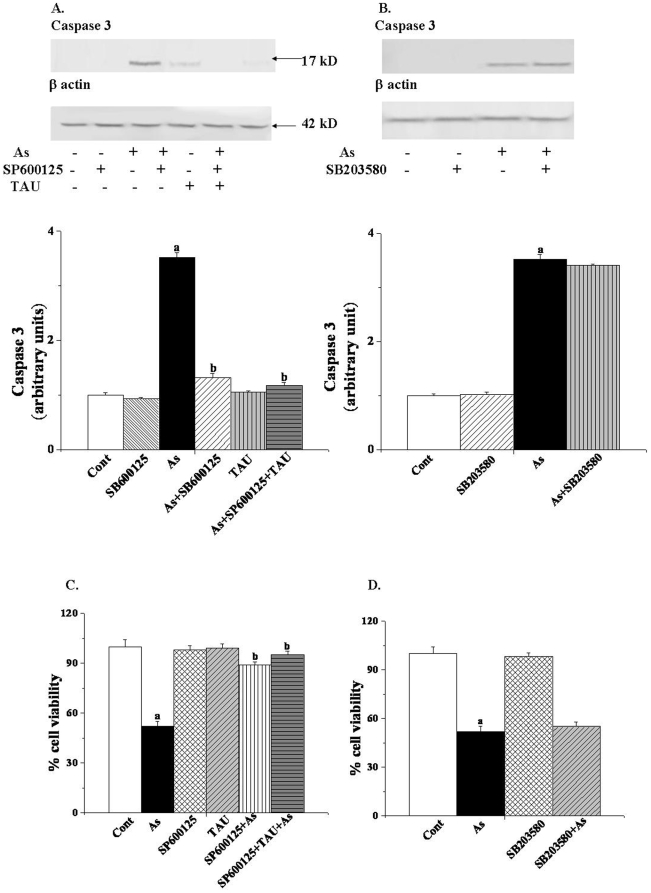
Immunoblot analysis of caspase 3 and hepatocytes viability in response to SB203580 and SP600125.Hepatyocytes were pre-treated with 10 µM SB203580 and SP600125 for 15 min, then treated with As (10 µM), taurine (25 mM, added 1 h prior to As treatment) for 8 h. Panel A: effects of SP600125 on Caspase 3, Panel B: effects of SB203580 on Caspase 3, β actin was used as an internal control. Panel C: effects of SP600125 on cell viability, Panel D: effects of SB203580 on cell viability. Data represent the average ± SD of 6 separate experiments in each group. “a” indicates the significant difference between the normal control and As treated groups, “b” indicates the significant difference between the As treated and taurine treated groups. (Pa<0.05, Pb<0.05).